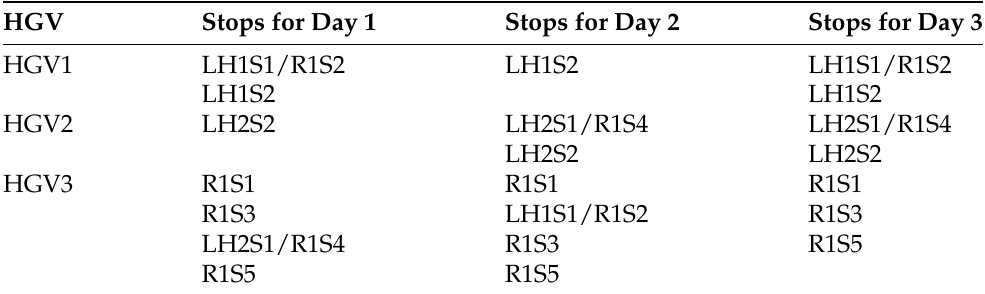
Table 4. Results of the optimisation problem to determine at which stops each HGV should deliver goods to minimize the total fuel consumption.